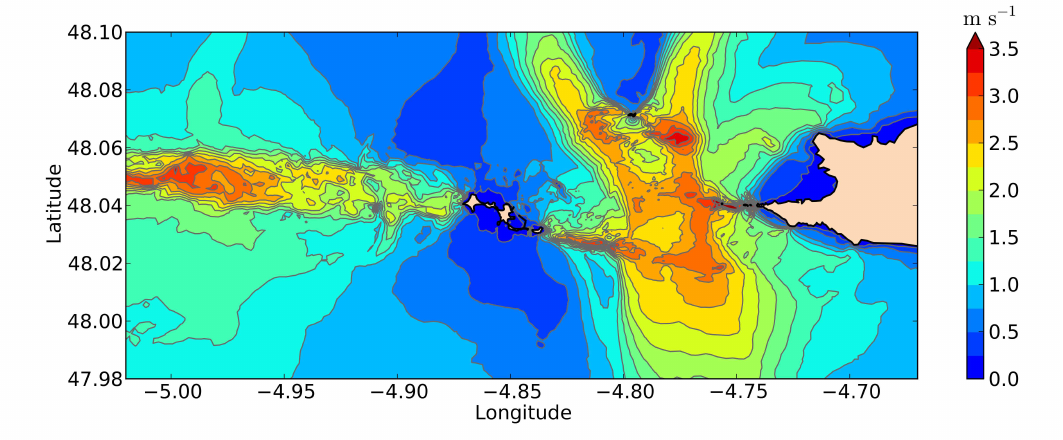
Figure 4. Maximum amplitude of depth-averaged tidal currents over a mean spring tidal